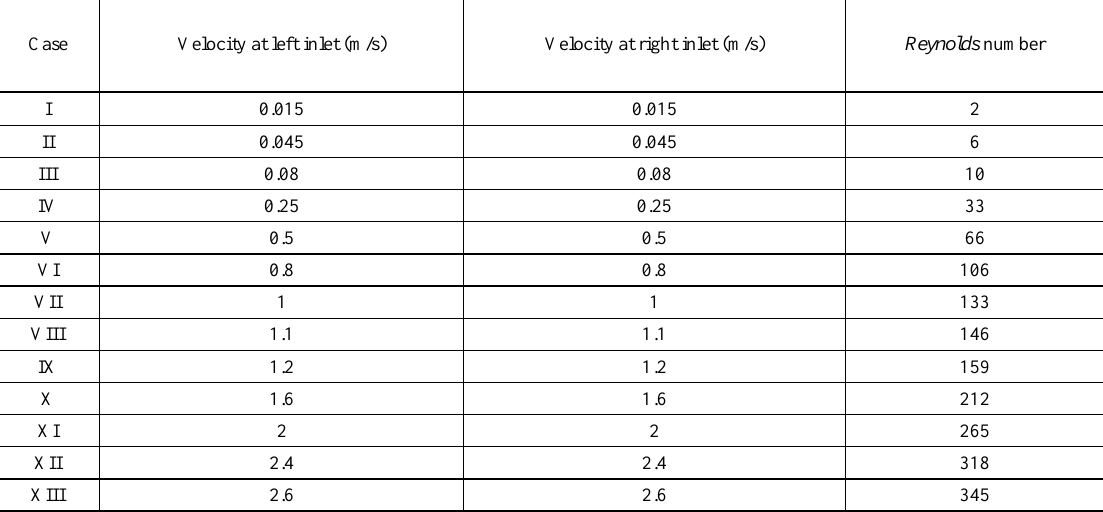
Table 1. Boundary conditions used in numerical simulations